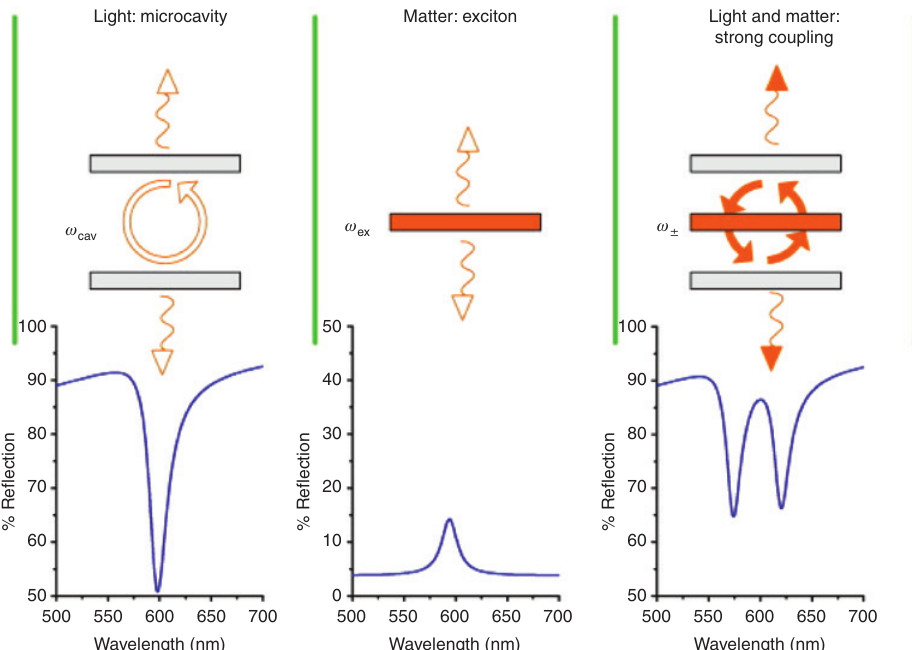
Figure 2: Sketch of the reflectance spectra showing the results of the strong coupling of light and matter. The microcavity (light) and matter (exciton layer) are provided with resonant frequencies of X integrated system represents new resonances at +